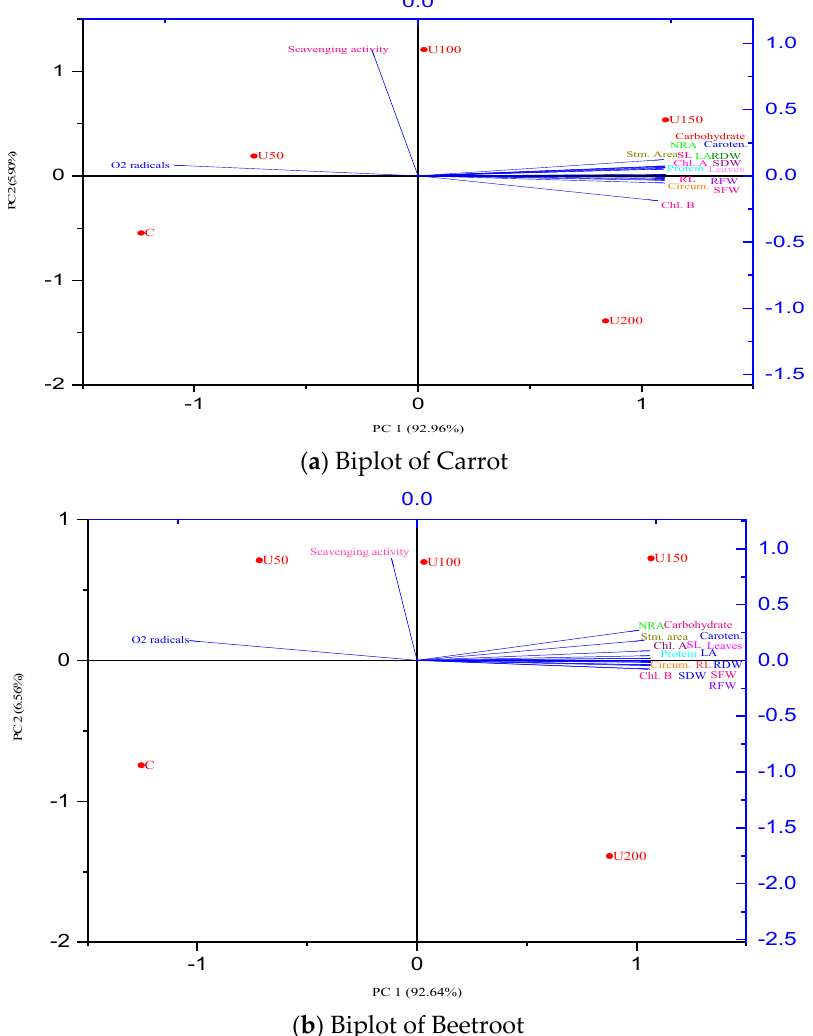
Figure 11. The biplots of PCA for carrot ( a ) and beetroot ( b ) presenting the impact of different levels of N on the studied parameters of carrot and beetroot; SL = shoot length; SFW = shoot fresh weight; SDW = shoot dry weight; LA = leaf area; RL = root length; Circum. = root circumference; RFW = root fresh weight; RFW = root dry weight; Chl. A = chlorophyll a, Chl. B = chlorophyll b; Caroten. = carotenoids; NRA = nitrate reductase activity; O 2- radicals = superoxide anion radicals.